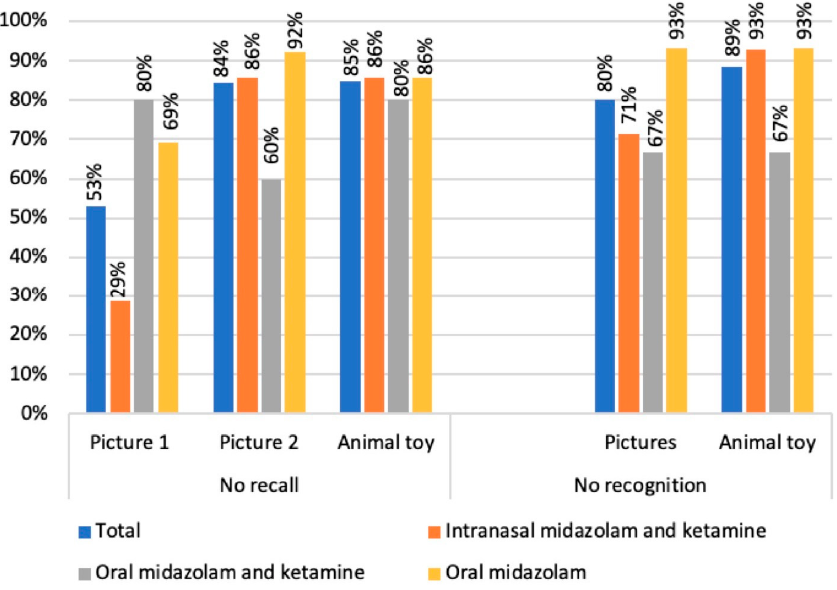
Figure 3. Occurrence of no recall and no recognition of pictures/animal toy among all the participants, and according to sedative groups.